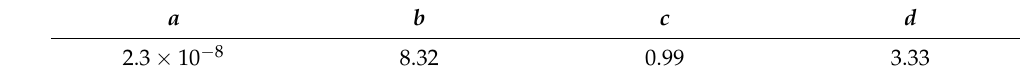
reduces the number of cycles required for failure to occur.